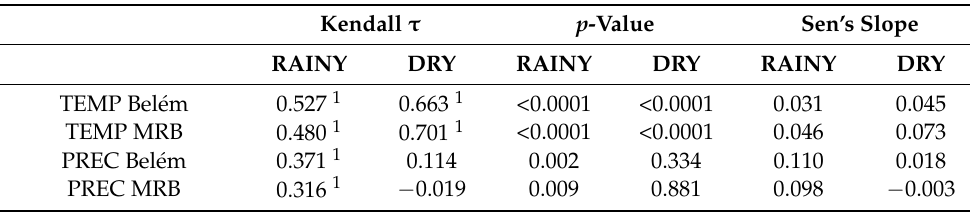
Table 2. Mann–Kendall test with the values of τ , p -value, and Sen’s slope for the series (1985–2020) of TEMP and PREC in Belém and MRB in the RAINY and DRY regimes.